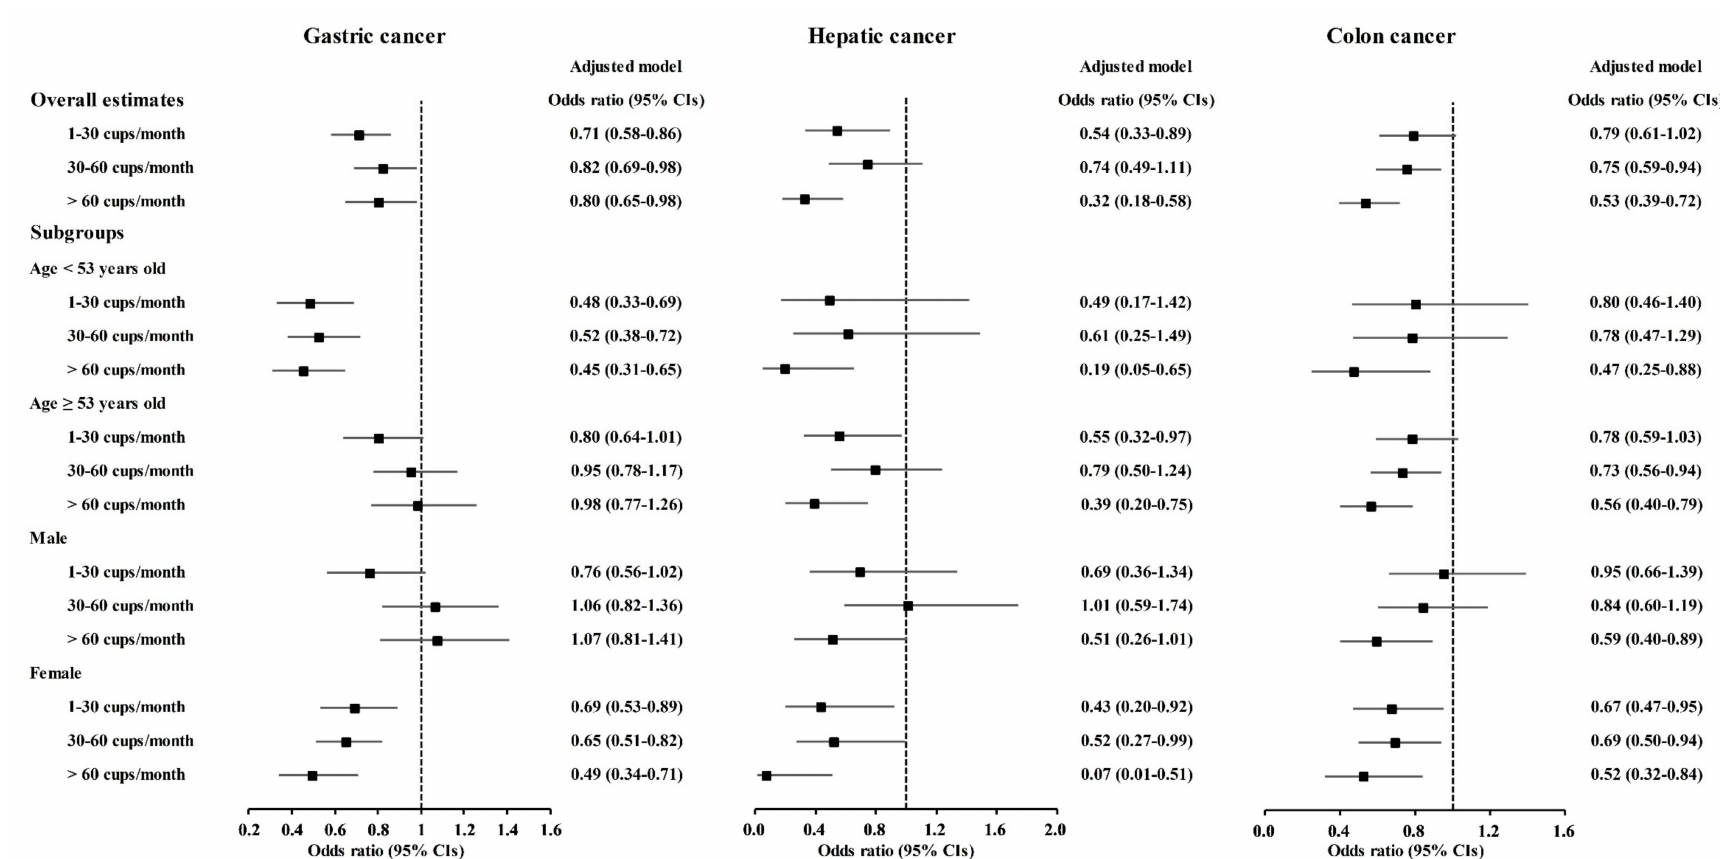
Figure 2. Odds ratios of coffee drinking habit for gastric cancer, hepatic cancer, and colon cancer histories according to age and